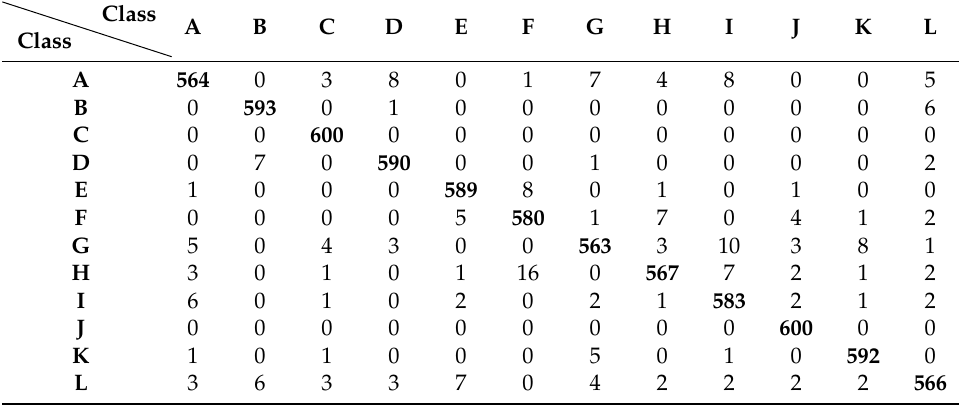
Table 11. Classification results after combination using DS theory for Elliptical and MLG